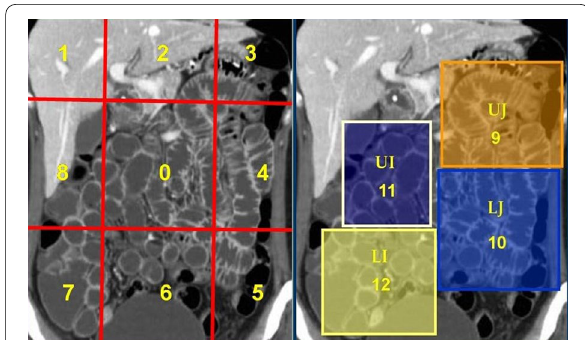
Fig. 1 Sugarbaker’s peritoneal cancer index (PCI) divides the peritoneal cavity into 9 abdominopelvic regions (0 central, 1 right hypochondrium, 2 epigastrium, 3 left hypochondrium, 4 left paracolic gutter, 5 left iliac fossa, 6 pelvis, 7 right iliac fossa, 8 right paracolic gutter) and 4 enteric regions (9 upper jejunum, 10 lower jejunum, 11 upper ileum, 12 lower